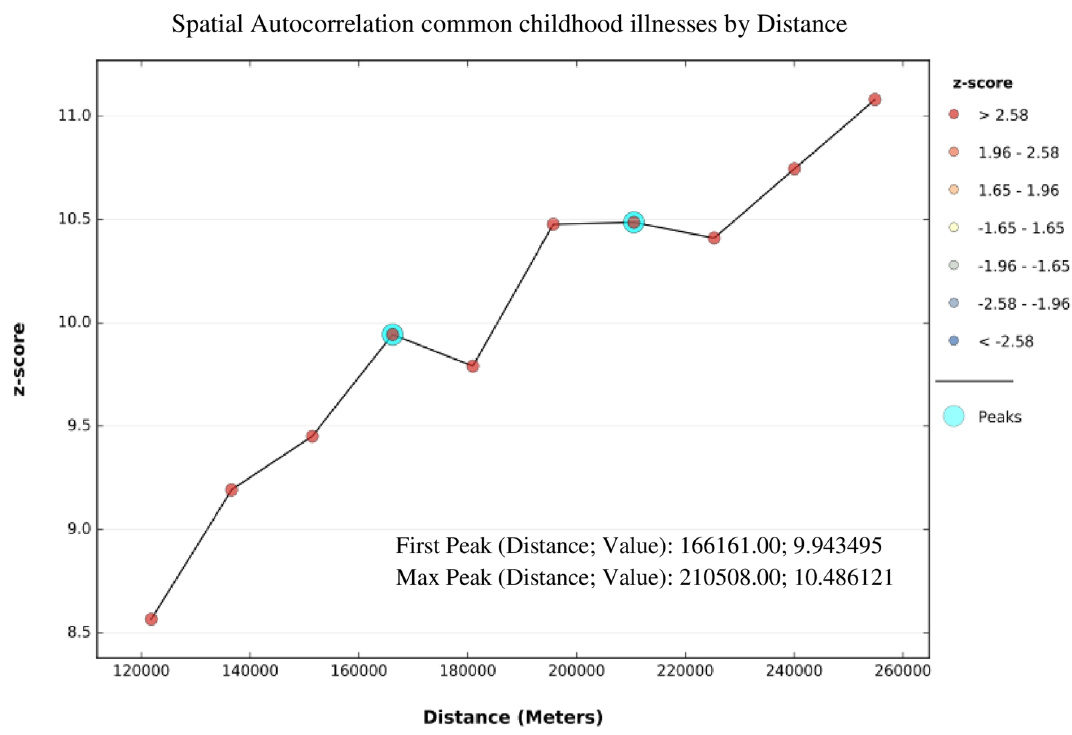
Figure 2. Incremental autocorrelation of common childhood illnesses among under-five children in Ethiopia, 2016 EDHS.